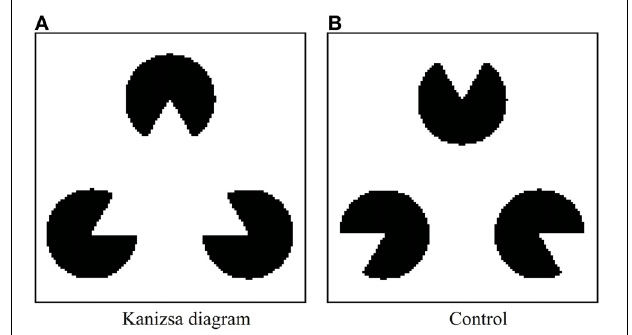
FIGURE 3 | Thickness rules. (i) If GP is dark and EP is bright, then c ( GP ) = 0, and the covered area decreases. Conversely, (ii) if GP is bright and EP is dark, then c ( EP ) = 1, and the covered area increases.